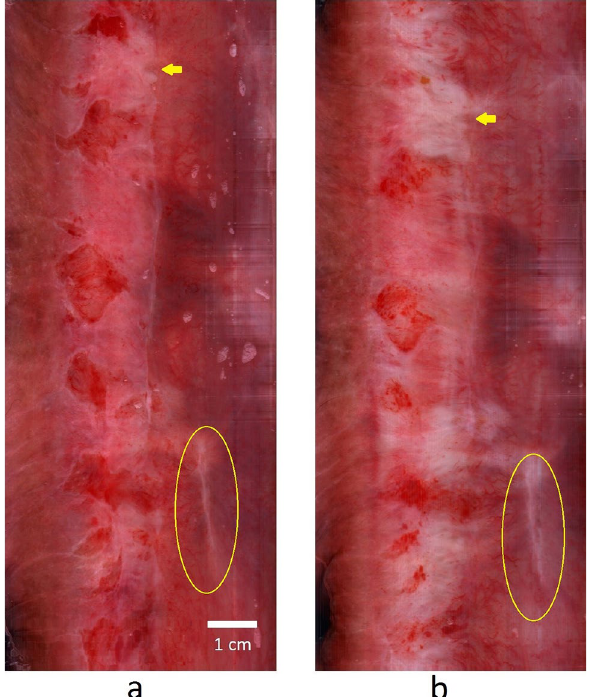
Figure 2. Serial images demonstrate acetic acid induced changes in the anal canal epithelium. The wide field- of-view (FOV) image of the anal canal ( a ) pre-acetic acid and ( b ) post-acetic acid. The increased whiteness (arrow) is the noted effect of acetic acid instillation. The yellow circle identifies a surgical scar in the pre-acetic acid and in the post-acetic acid